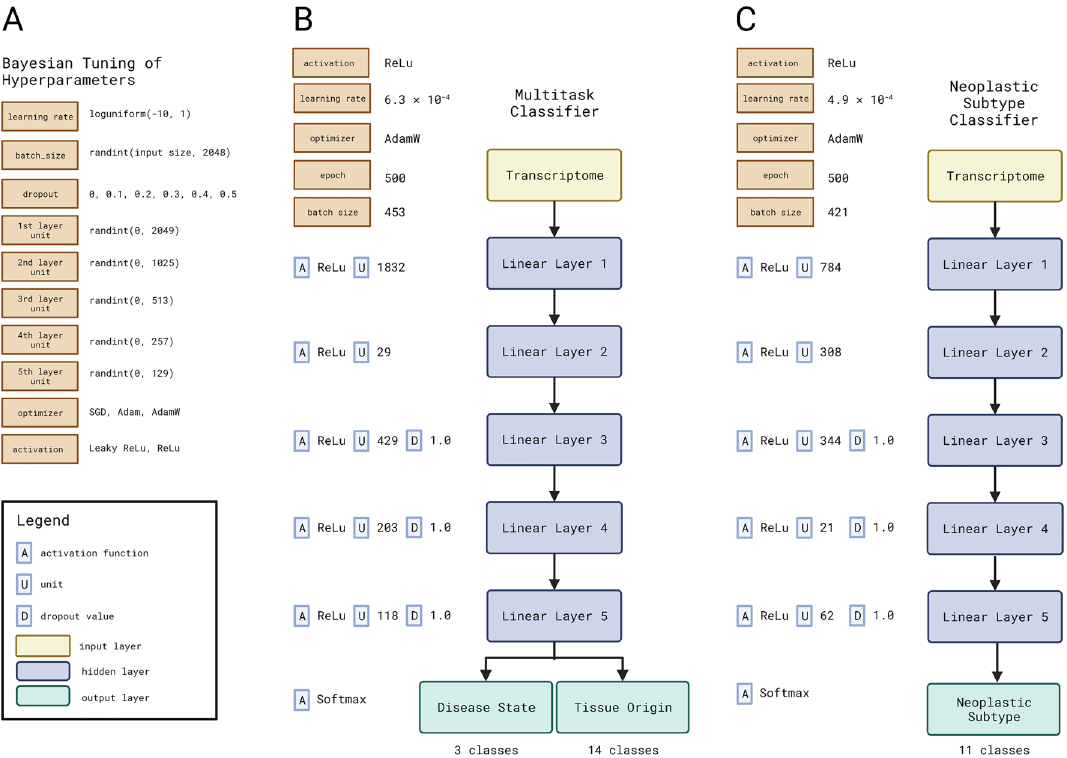
Figure 1. Bayesian Hyperparameter Tuning of Deep Learning Models. ( A ) Search space of hyperparameters for Bayesian tuning; ( B ) Architecture of multitask classifier for disease state and tissue origin along with tuned hyperparameters; ( C ) Architecture of neoplastic subtype classifier along with tuned